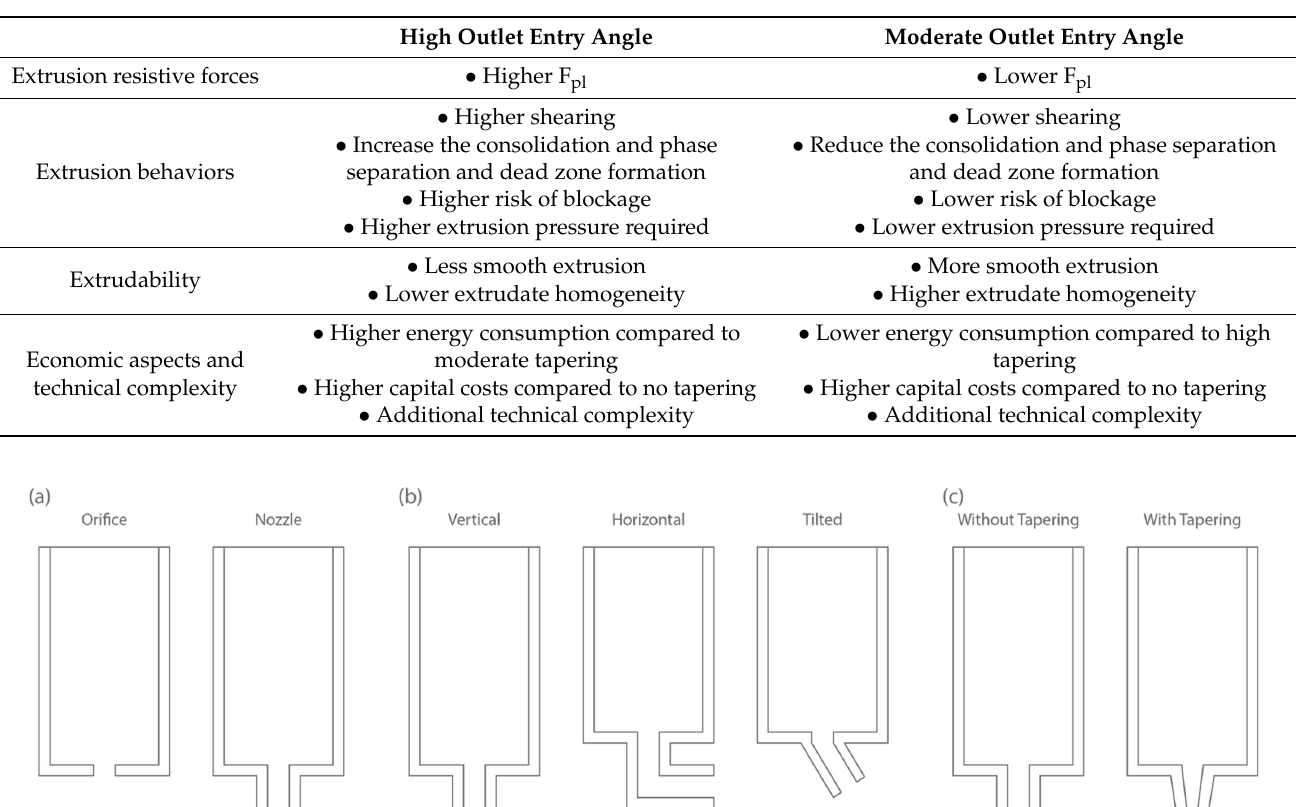
Table 4. The effects of chamber tapering on the extrusion forces, extrusion behaviors, extrudability and economic aspects and technical complexity based on the same material design and operational design.